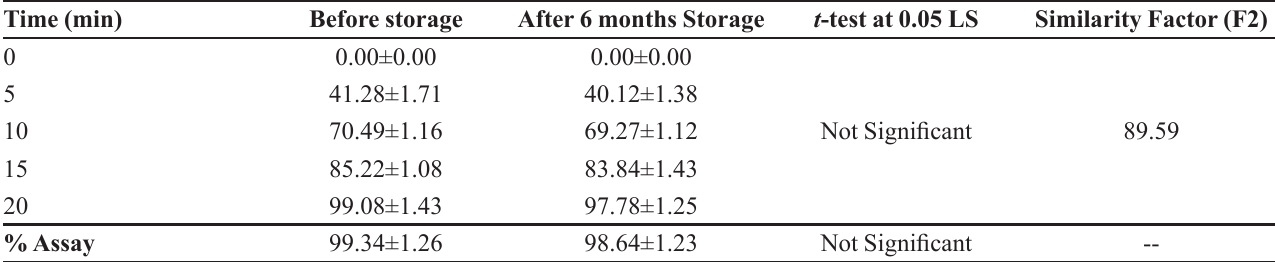
TABLE VIII - Stability study data of ODTs containing SD8 (Mean ± SD, n=3) Time (min) Before storage After 6 months Storage t -test at 0.05